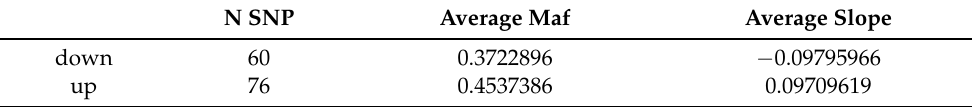
Table 5. Expression quantitative trait locus (eQTL) altering expression level TMPRSS2. N SNP